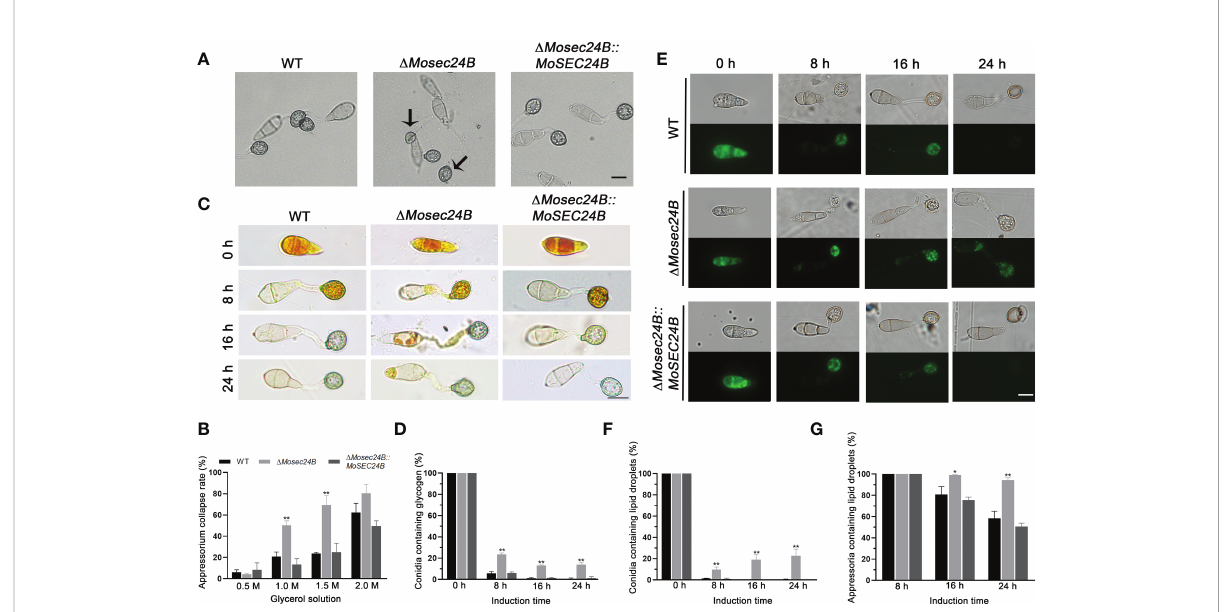
FIGURE 5 MoSec24B affects appressorium turgor and the mobilization of glycogen and lipid droplets. (A) Treatment with 1.0 M glycerol for appressoria collapse. Scale Bar = 10 m m. (B) Appressorium collapse rates of WT, D Mosec24B , and D Mosec24B::MoSEC24B strains under 0.5 – 2.0 M glycerol treatment. (C) Cellular distribution of glycogen in conidia and appressoria was observed at 0 – 24 (h) The staining of the samples with I 2 /KI solution showed a dark brown color of glycogen under a white light microscope. Scale Bar = 10 m m. (D) The number of conidia containing glycogen as a percentage. (E) Cellular distribution of lipid droplets in conidia and appressoria was observed at 0 – 24 (h) Samples were stained with BODIPY solution, and lipid droplets displayed green fl uorescence under a fl uorescence microscope. Scale Bar = 10 m m. (F) The number of conidia containing lipid droplets as a percentage. (G) The number of appressoria containing lipid droplets as a percentage. Error bars represent the standard deviation. An analysis of the data was carried out using an unpaired two-tailed Student ’ s t-test. Asterisks represent statistically signi fi cant differences in the data (**P < 0.01, *P <